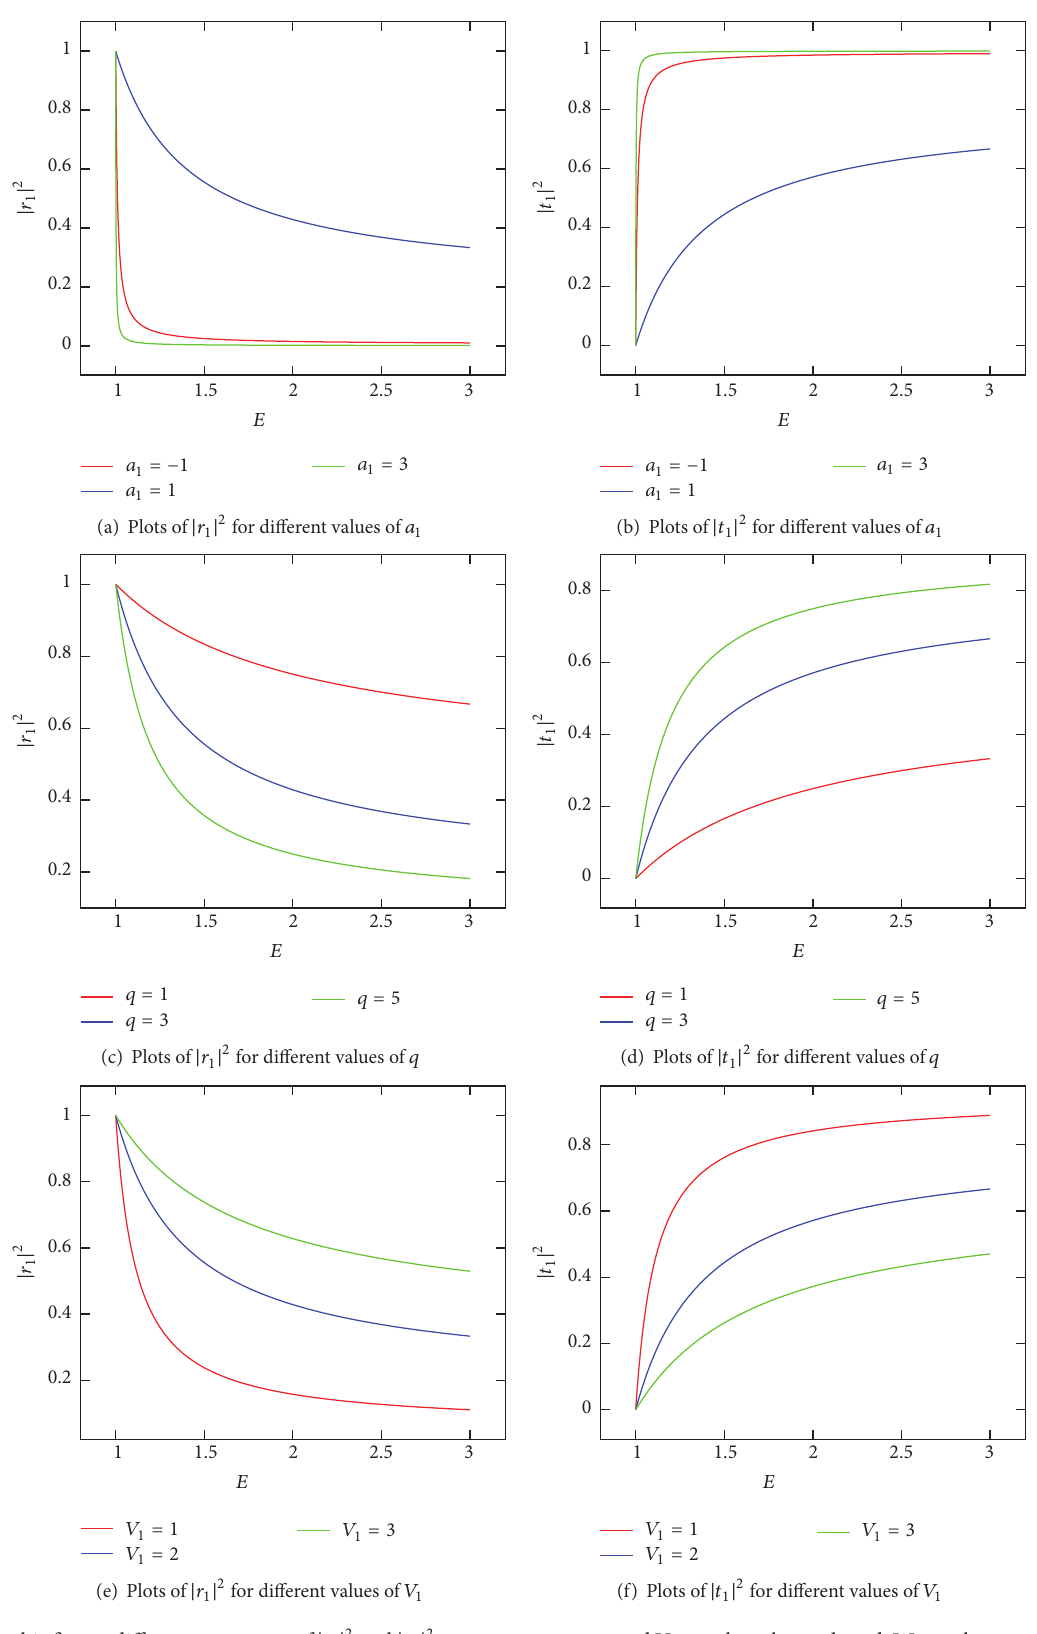
(f) Plots of |𝑡 1 | 2 for different values of 𝑉 1 Figure 2: In this figure, different treatments of |𝑡 1 | 2 and |𝑟 1 | 2 as parameters 𝑎 1 , 𝑞 , and 𝑉 1 vary have been plotted. We set the parameters in (a) and (b) 𝑉 1 = 2 , 𝑞 = 3 , (c) and (d) 𝑉 1 = 2 , 𝑎 1 = 1 , and (e) and (f) 𝑞 = 3 , 𝑎 1 = 1